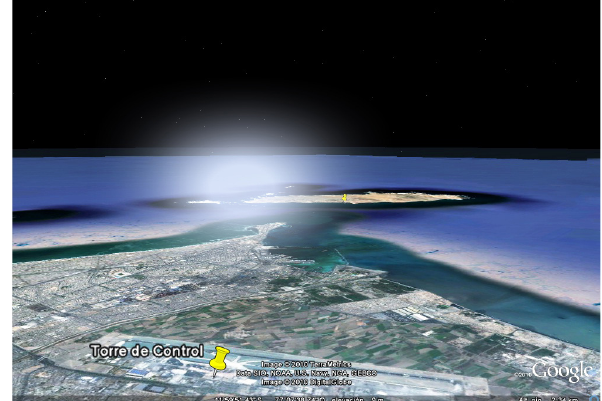
Fig. 2. View from the cockpit of a Beechcraft plane on its landing approach. Fig. 3. View from the Control Tower at the Lima International Air- port. Although this view corresponds to a higher altitude position, it illustrates the diffused nature and broad view of the lights reported as coming from the ocean between the coast and the